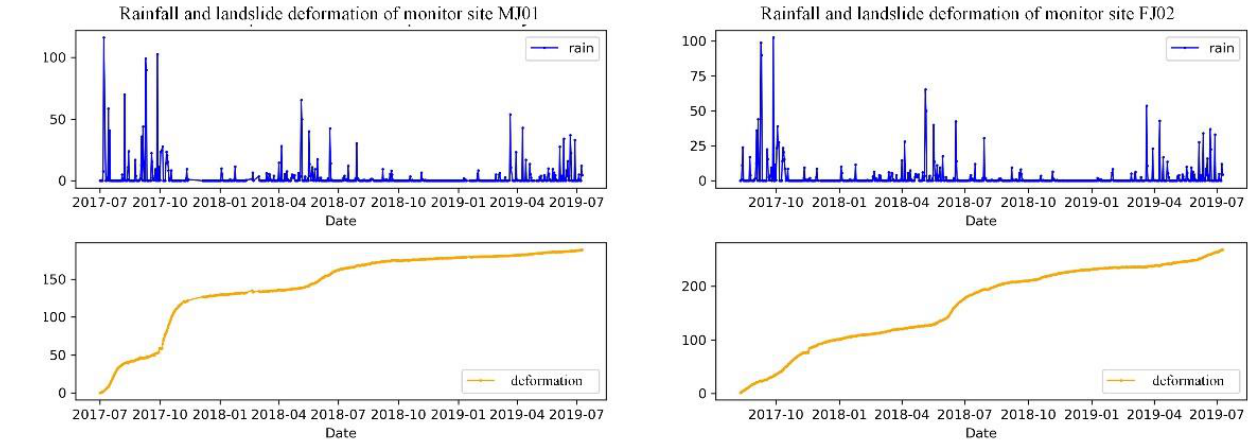
Figure 6. Partly map of monitoring data of the regional rainfall-induced landslide.